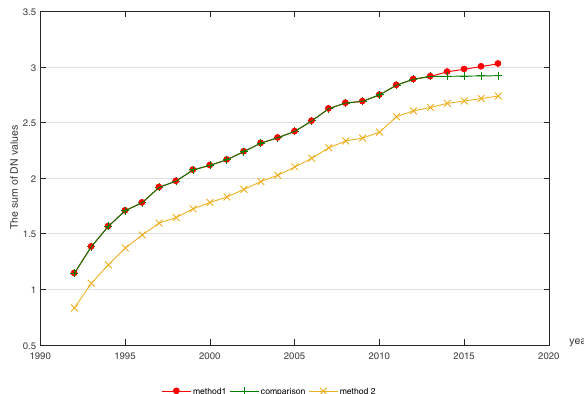
Figure 1. The total trend of the SDN values during 1992–2017 (unit of the SDN values: 10 7 ). Notes : (1) method 1 represents the results based on D 1 data; (2) method 2 represents the results based on D 2 data; and (3) the comparison curve represents the results without the inter-calibration between DMSP/OLS and NPP/ VIIRS images, revealing the gap between the two satellite’s images and indicating the significance of the inter-